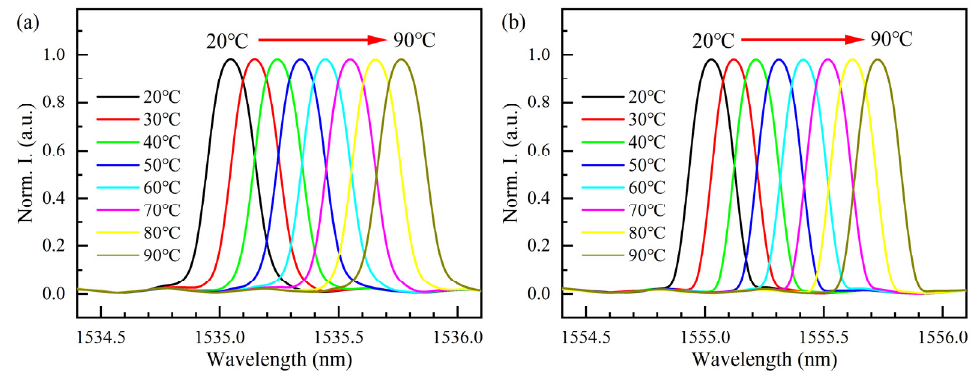
Figure 4. Normalized spectral reflectance of sensor group 1 under temperature experiment: ( a ) FBG1 at different temperatures; ( b ) FBG2 at different temperatures.